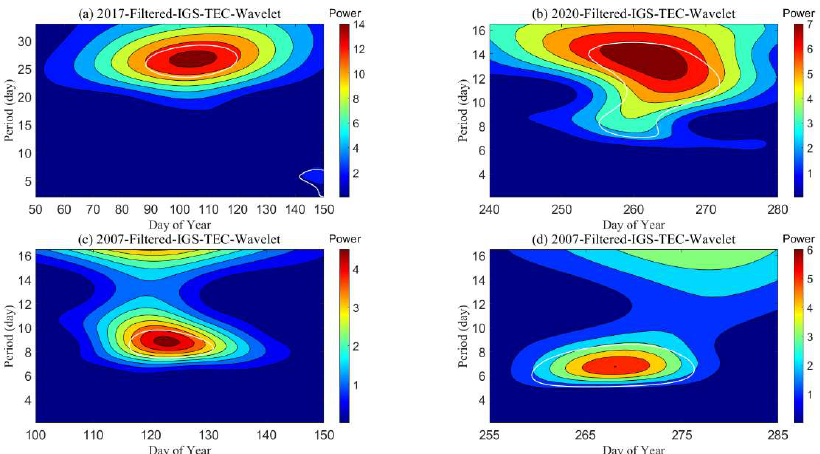
Figure 4. Examples of the ionospheric oscillations with period centering at the four harmonic periods of solar rotation.